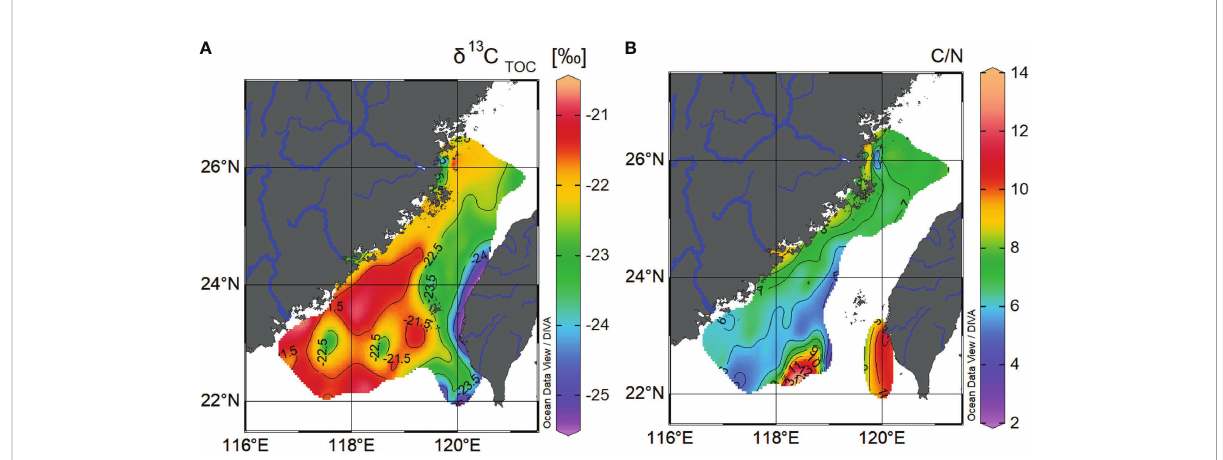
FIGURE 8 Spatial distributions of d 13 C TOC (A) and C/N ratio (B) in the TS surface sediments. One data point within the Jiulong estuary (117.784°E, 24.481°N) and the averaged signal calculated from 31 surface sediments within the Min estuary are included in order to constrain Chinese mainland- derived fl uvial OM origins into the TS from the west